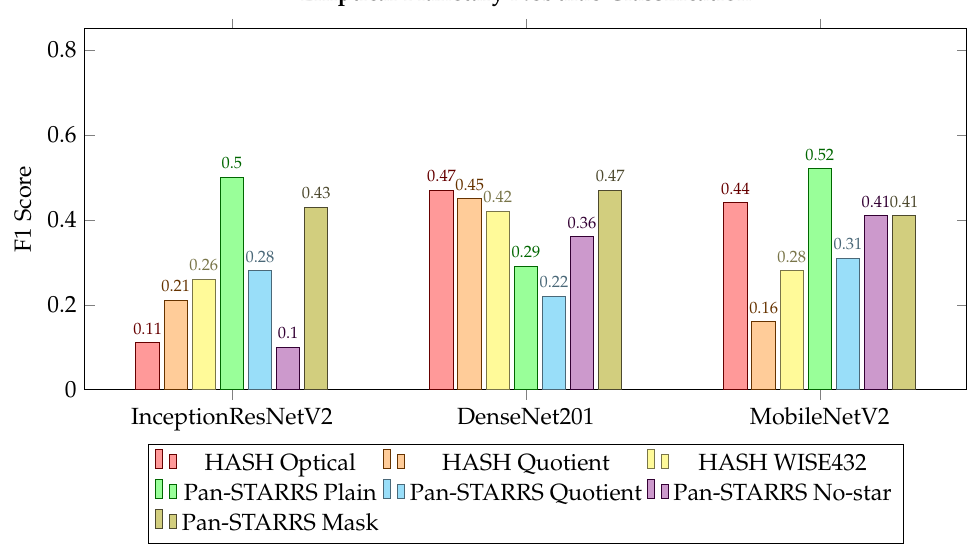
Figure 12. Elliptical planetary nebulae morphology classification F1 score using the Test set from HASH DB and Pan-STARRS.